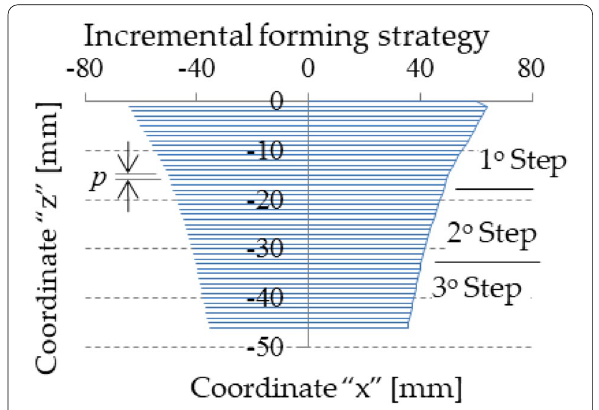
Figure 8 Incremental strategy applied during the hybrid process